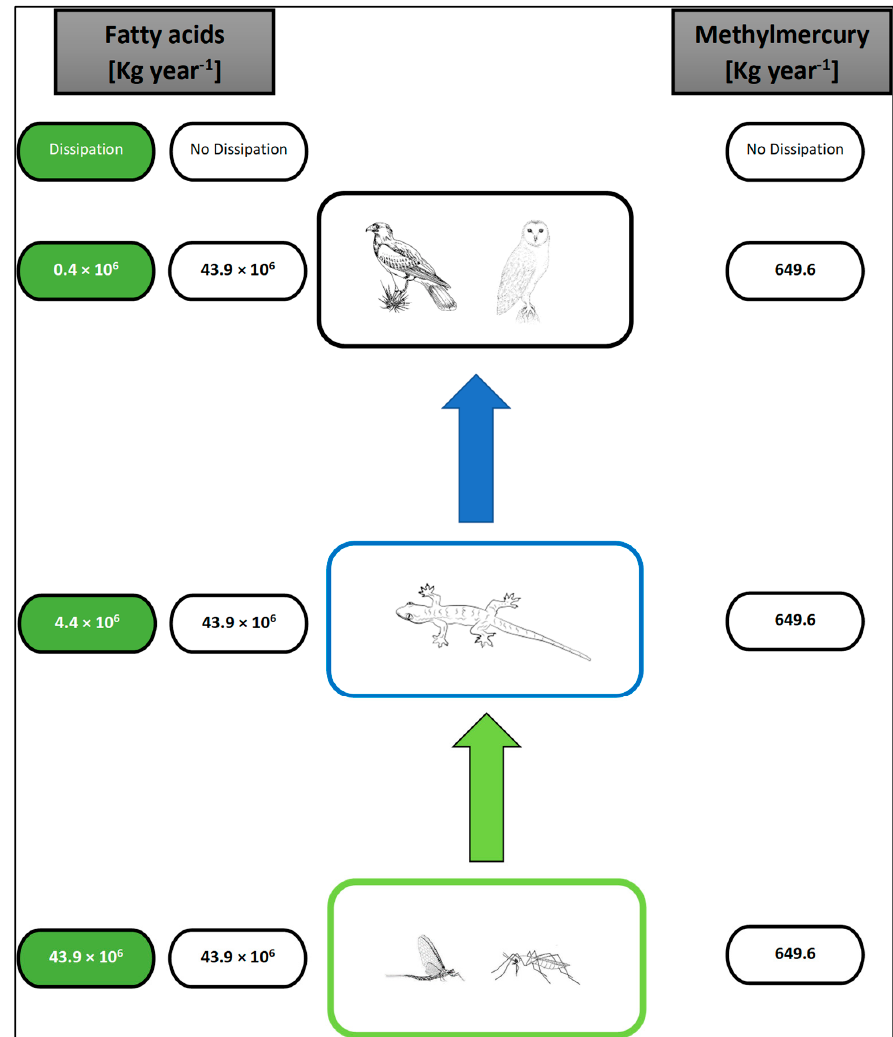
Figure 5. Depiction of the movement of physiologically important fatty acids and methylmercury (MeHg) as mediated my aquatic insects. Transfer efficiency based on traditional trophic pyramid concept of 10% dissipation at each trophic level.